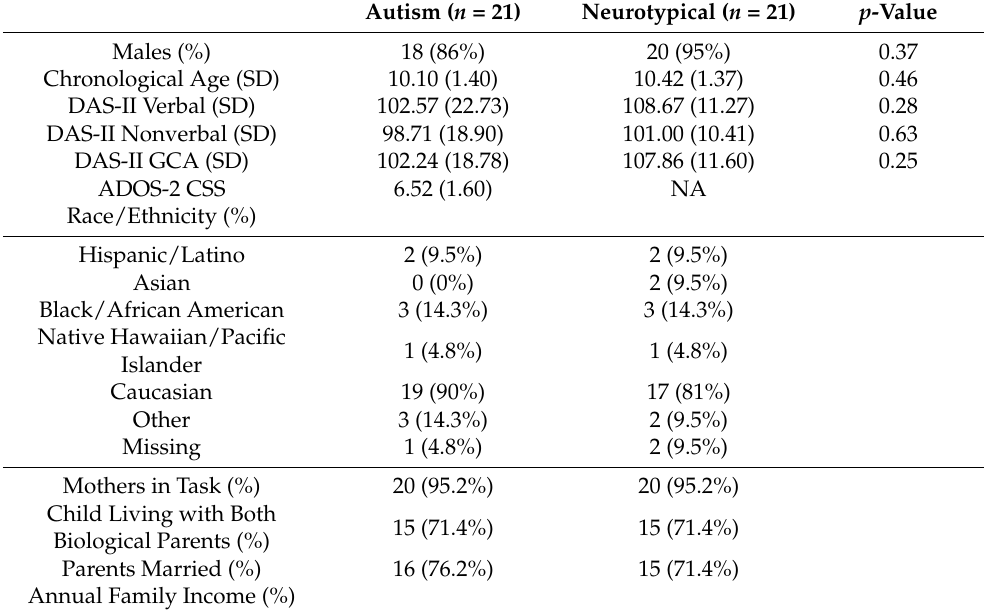
Table 1. Child and Family